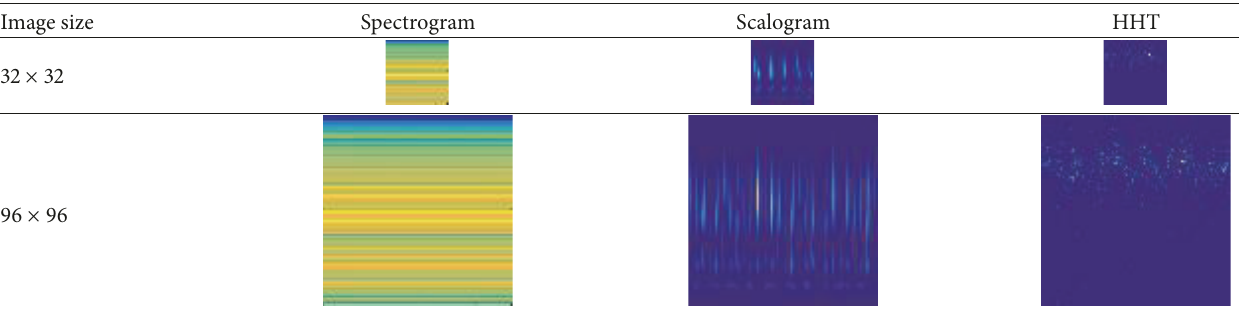
Table 15: CWR inner race images.